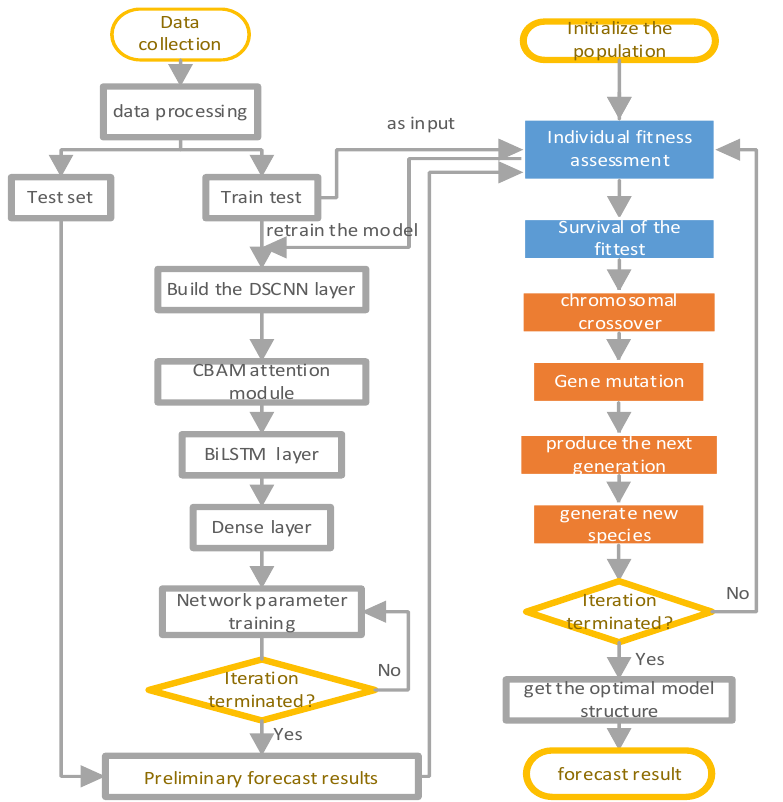
Figure 8. Genetic Algorithm optimization flow chart.